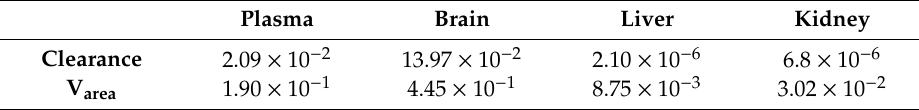
Table 4. The clearance and distribution (V area ) of Les-3833 in male Balb / c